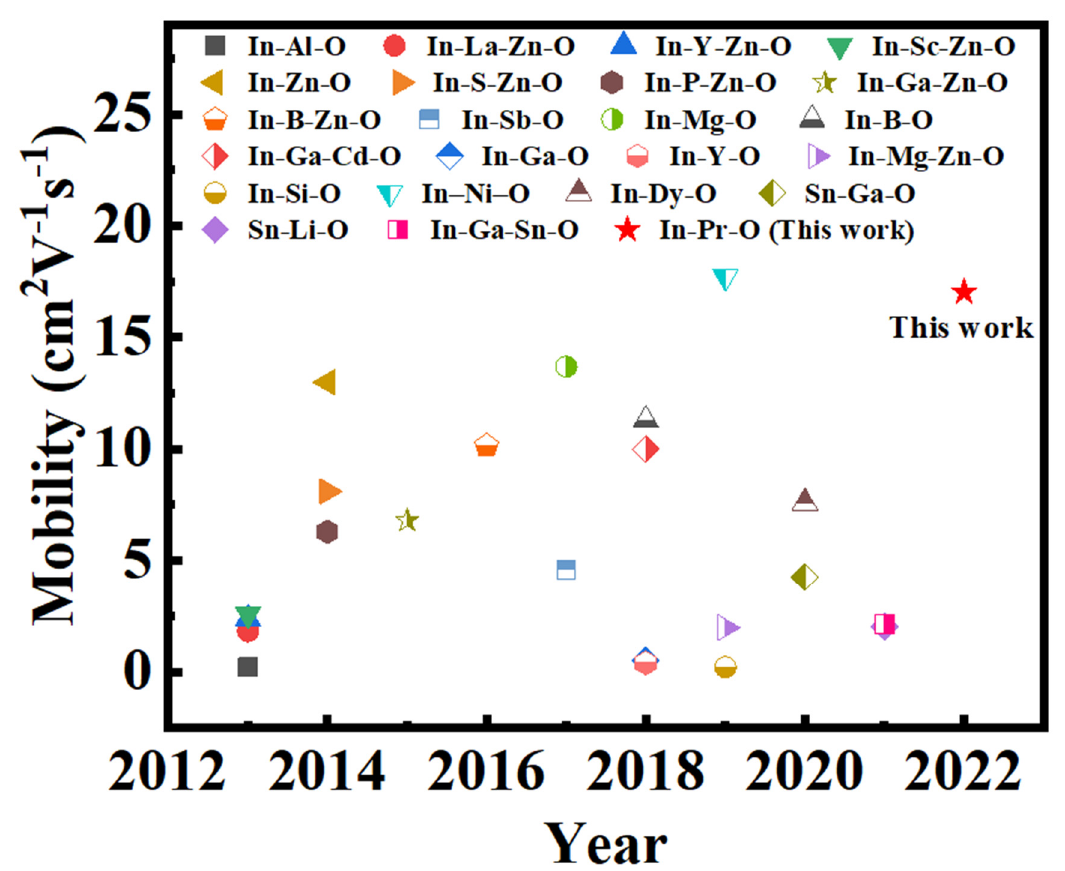
Figure 11. Recent advances of sol–gel oxide TFTs on Si/SiO 2 substrate.